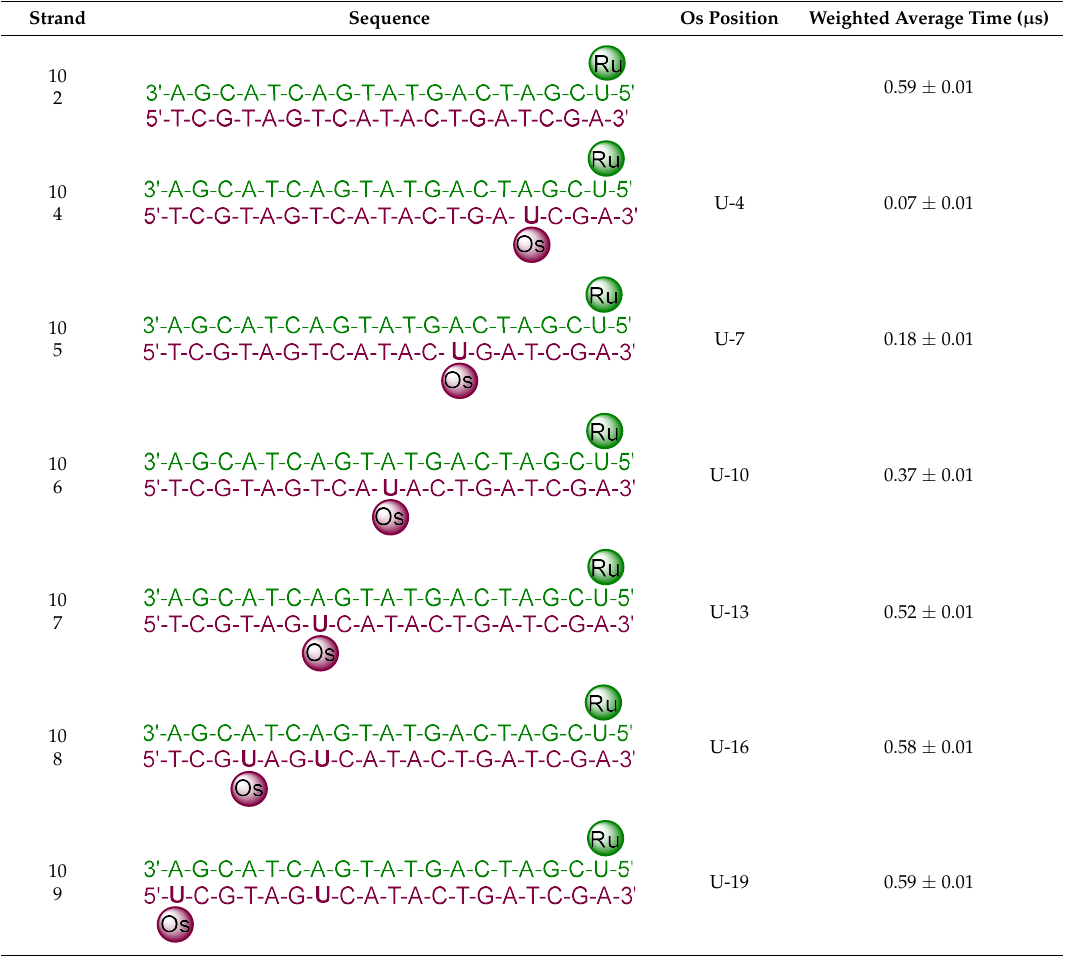
Table 4. Showing the position of the osmium acceptor, [Os(bpy) 2 (3-ethynyl-1,10-phenanthroline)] 2+ , in various 19-mer duplexes where the ruthenium donor position, 1, remains the same (U-19) [92]. Strand Sequence Os